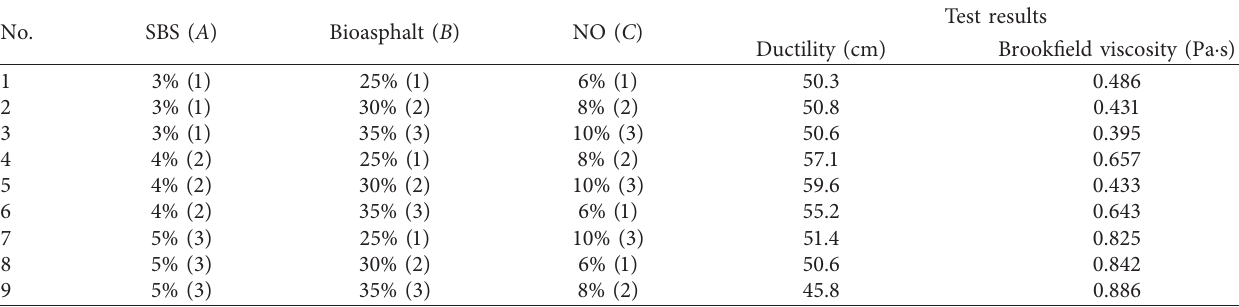
Table 3: Orthogonal experimentation test